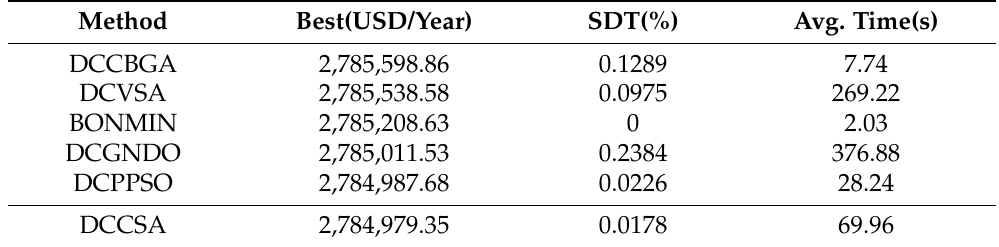
Table 6. Numerical performance comparison of the 69-bus feeder after 100 consecutive